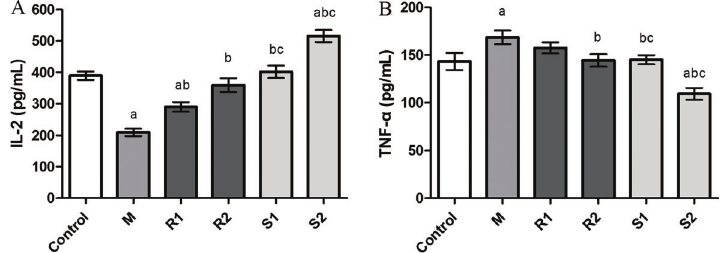
Figure 1. Levels of interleukin (IL)-2 ( A ) and tumor necrosis factor (TNF)- a ( B ) in rabbits with intestinal obstruction. M: intestinal obstruction group; R1: 2-day natural recovery group; R2: 4- day natural recovery group; S1: 2-day Sijunzi treated group; S2: 4-day Sijunzi treated